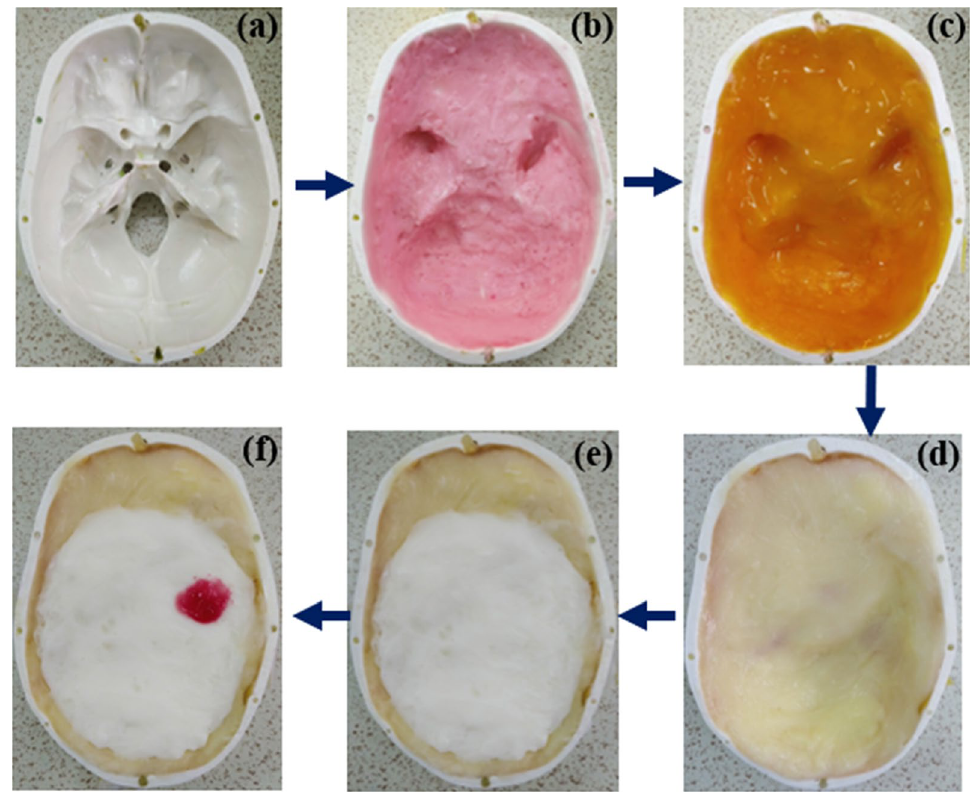
Figure 18. Steps of 3D head phantom fabrication. ( a ) Blank ( b ) Dura ( c ) CSF ( d ) gray matter ( e ) white matter ( f ) phantom with